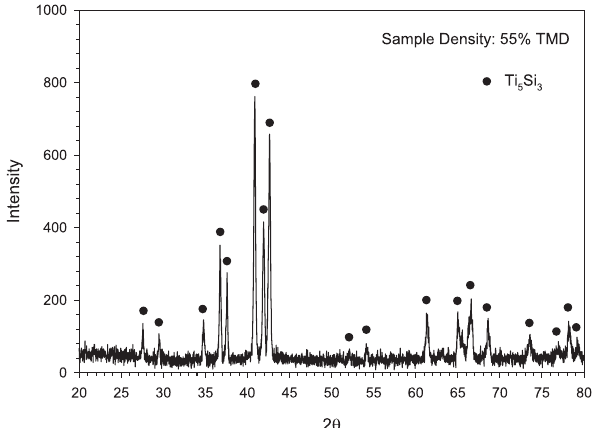
Figure 4: XRD pattern of an SHS-derived product from a powder compact with Ti:Si ¼ 5:3 and 55% TMD.